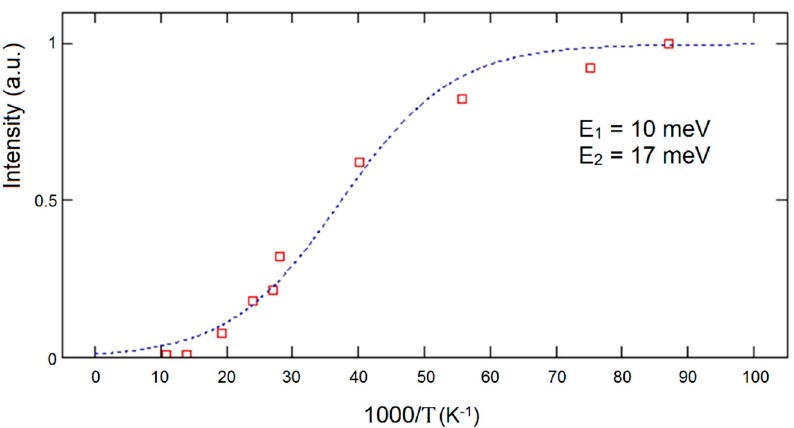
Figure 4. Temperature dependence of the PL intensity of the 1.53 transition in undoped cells along with the two-activation energy fit.